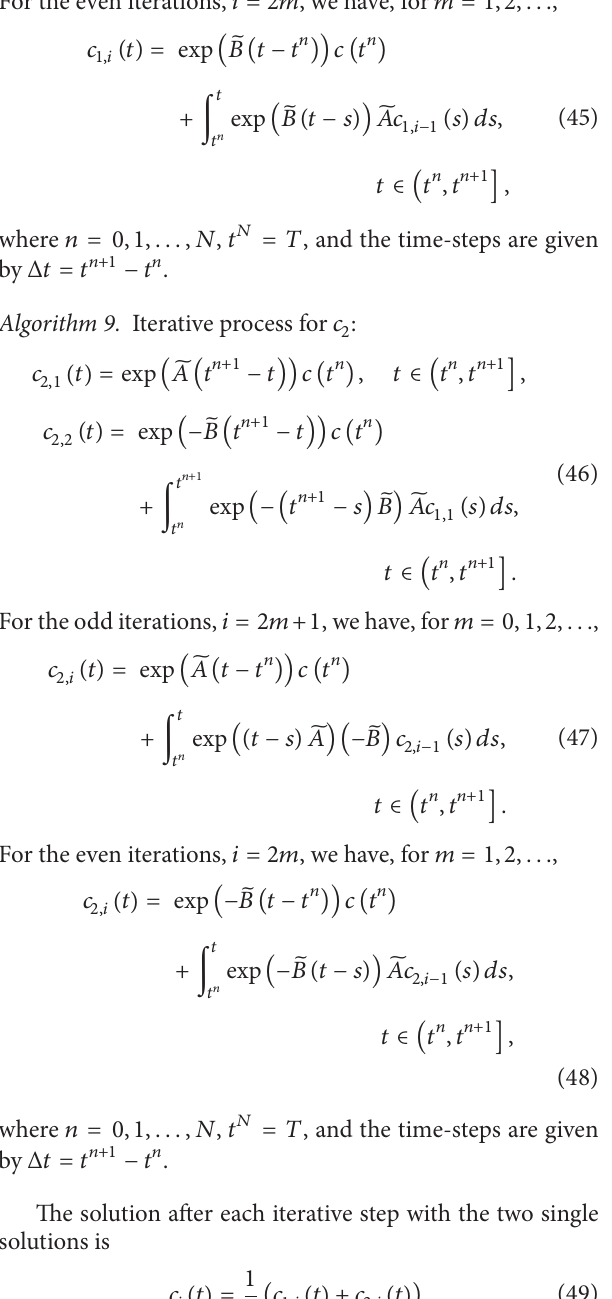
Table 3: The computational time of all three